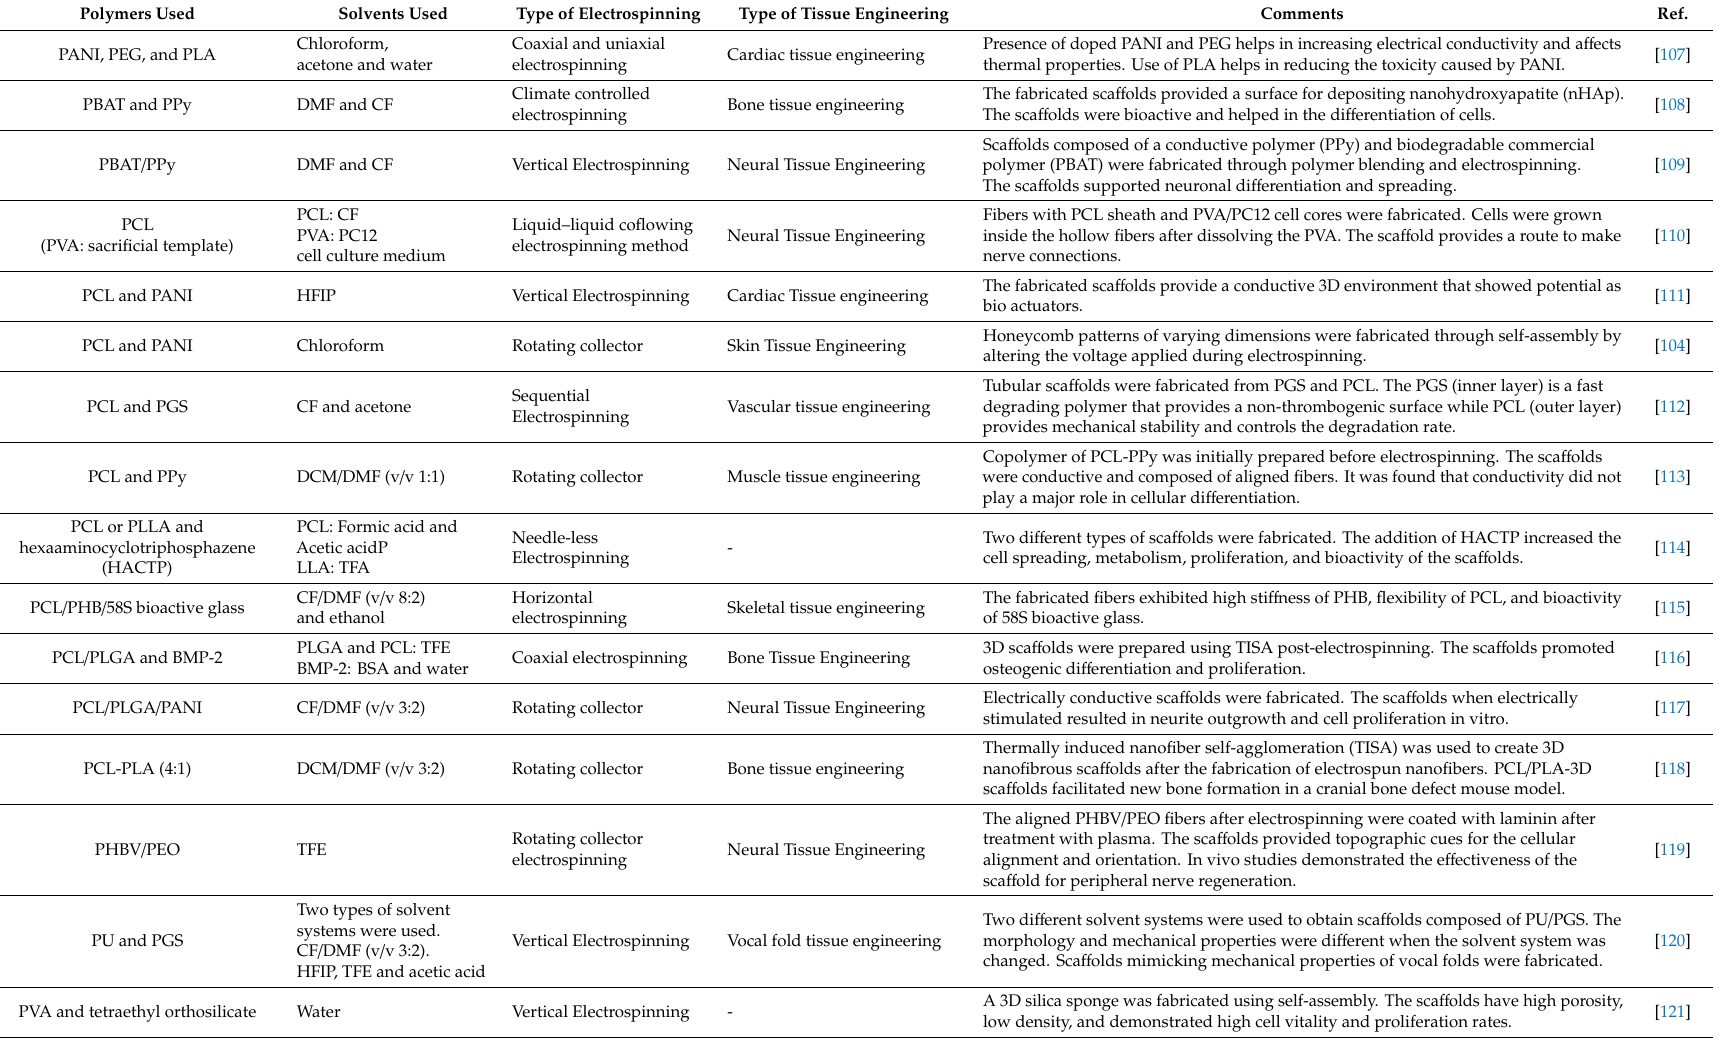
Table 3. Electrospun sca ff olds based on synthetic polymer